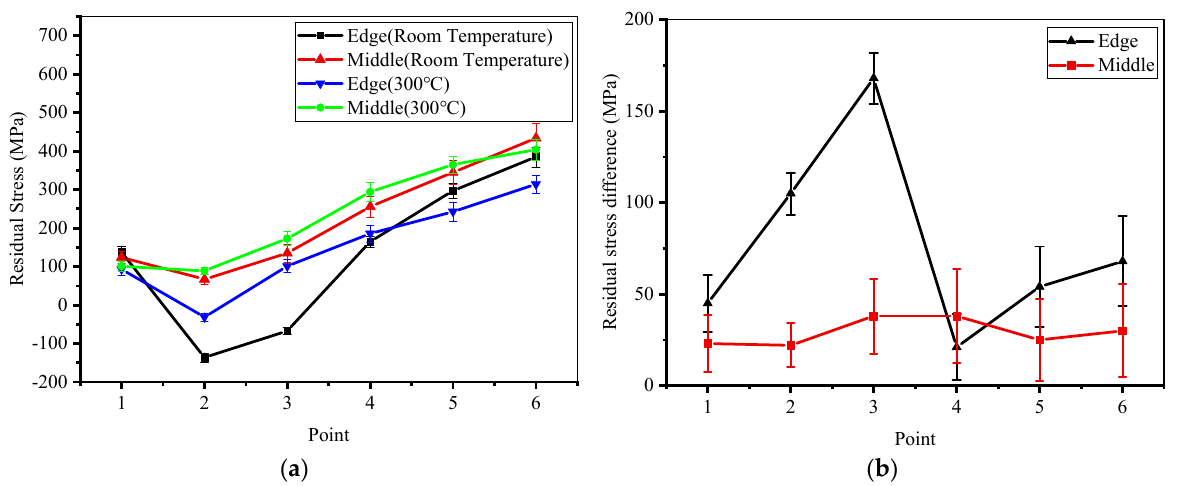
Figure 5. ( a ) Surface residual stress distribution of the FGM thin-walled samples; ( b ) residual stress difference at different height of the samples.